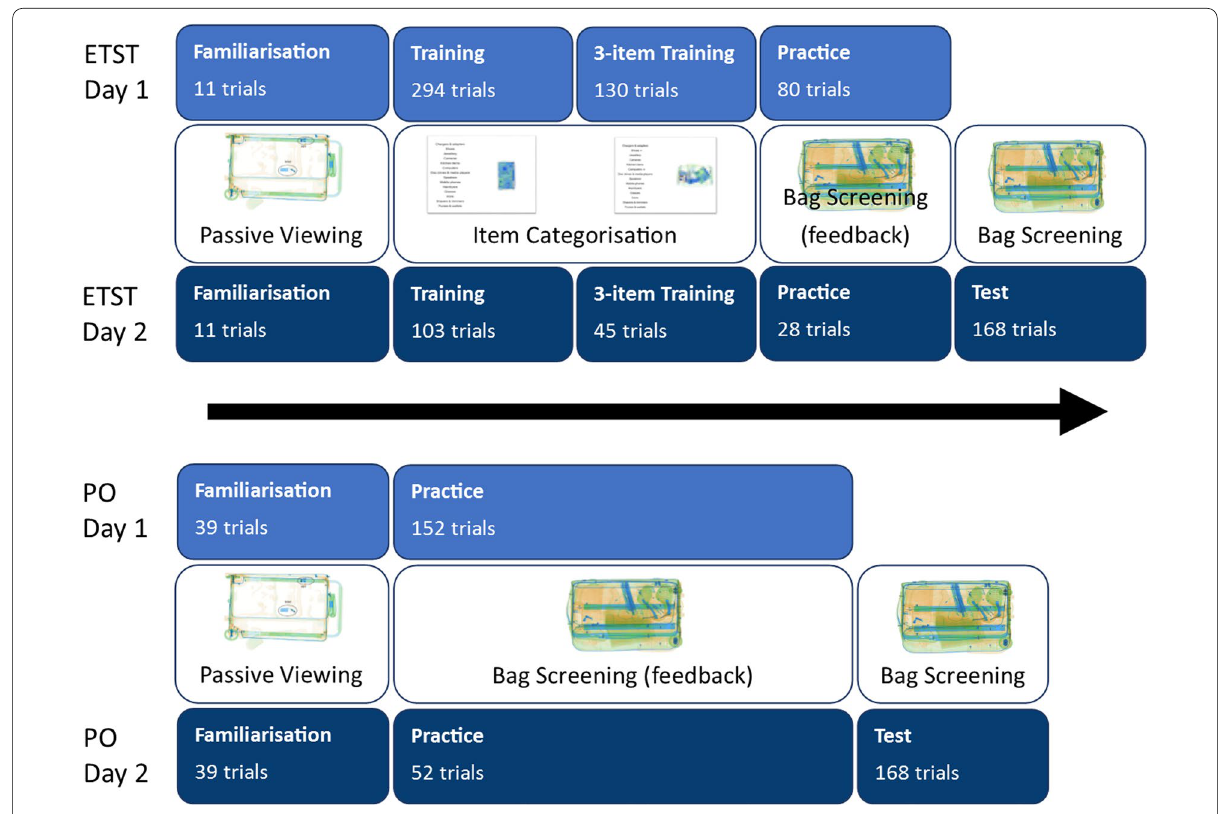
Fig. 10 Outline procedures for Experiment